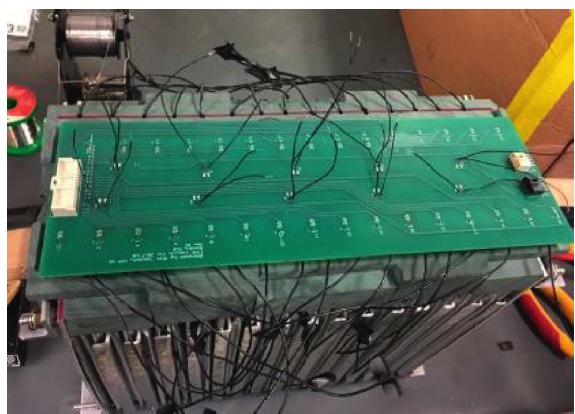
Figure 11: Battery pack without the box and insulation